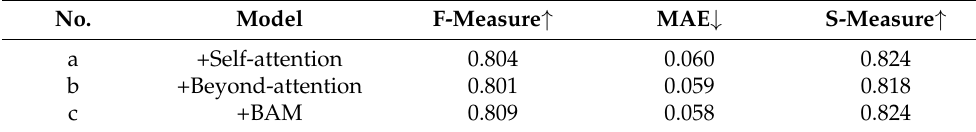
Table 2. The different models embedded and measured on the DUTS-TE datasets.